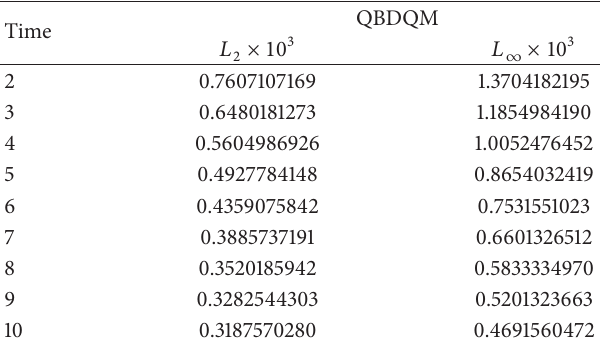
Table 6: 𝐿 2 and 𝐿 ∞ error norms for V = 0.01 , Δ𝑡 = 0.01 , and 𝑁 = 81 at 0 ≤ 𝑥 ≤ 1.3 .